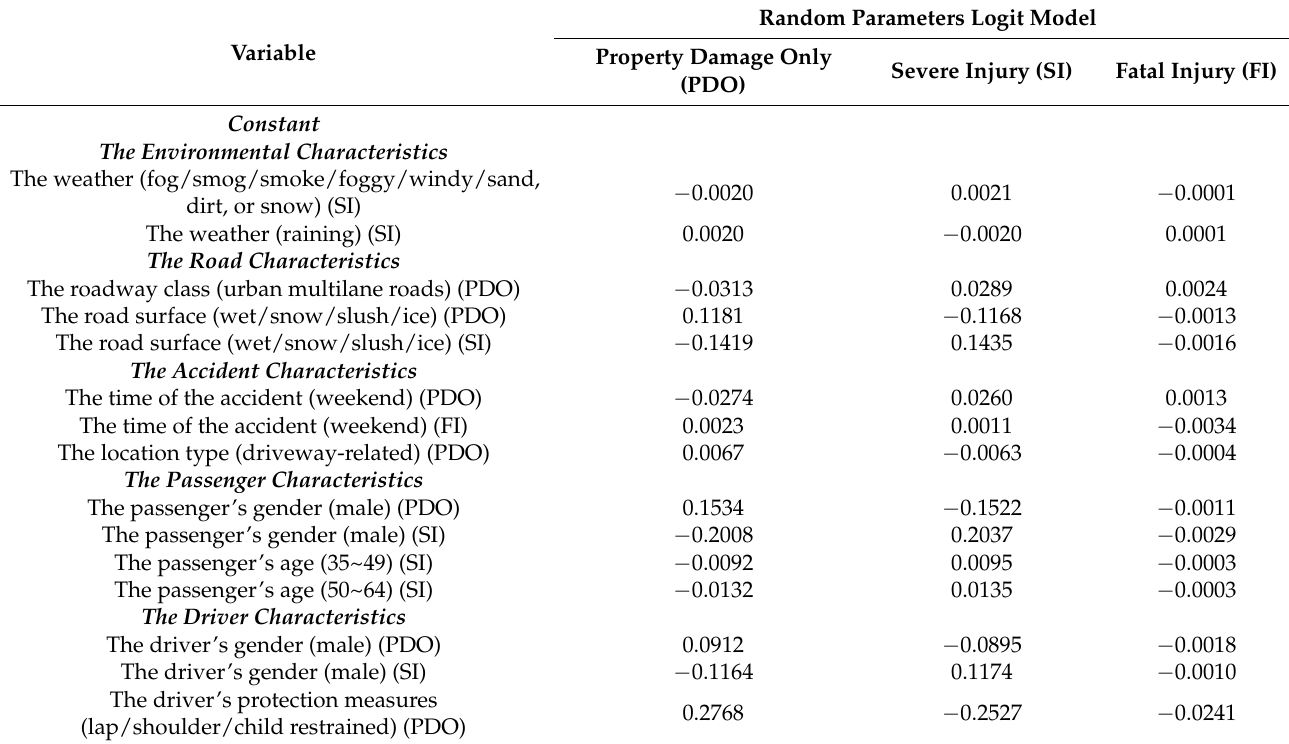
Table 9. The marginal effects of 2018 in daylight conditions with street lighting